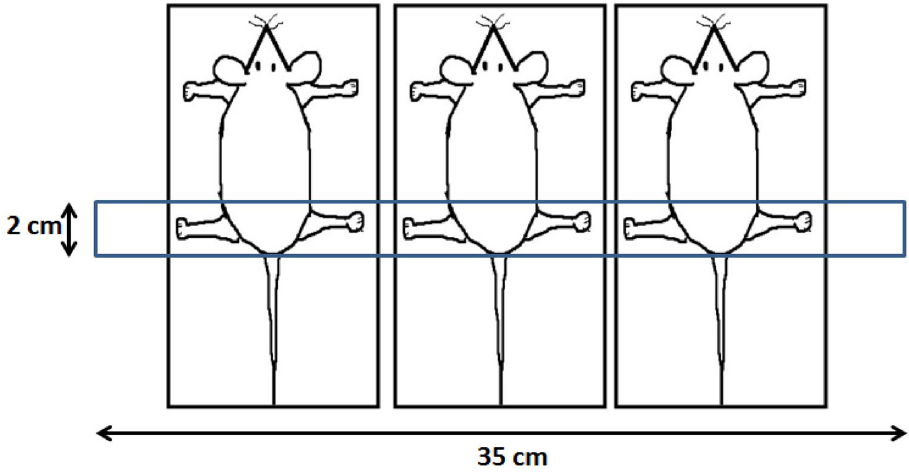
Figure 1. Representative image of animal exposure with γ-rays in a field size of 2 cm × 35